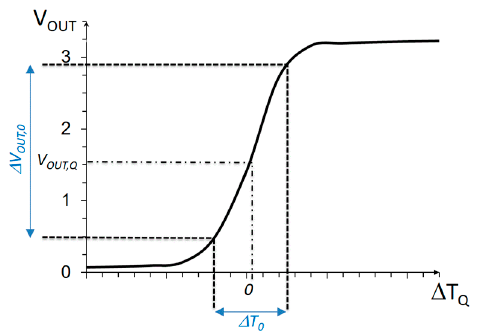
Figure 4. Typical characteristic curve of the core temperature sensor in Figure 3.